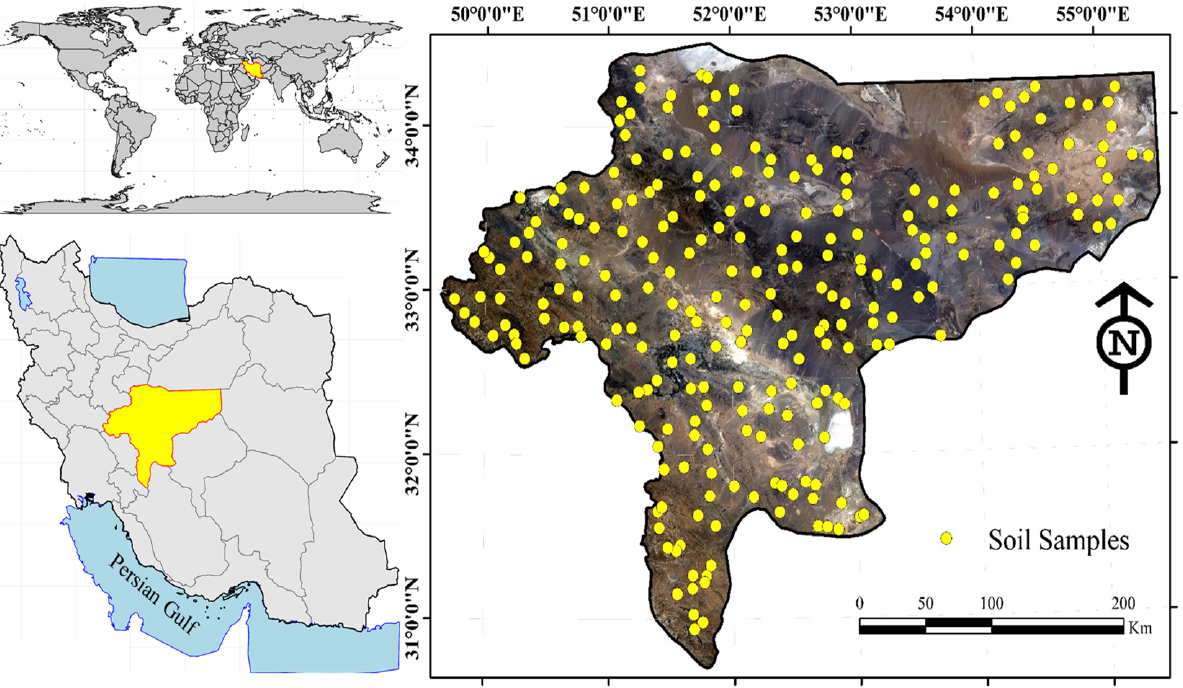
Figure 1. The location of Iran and the Isfahan province ( left ) and the spatial distribution of sampling points ( right ).